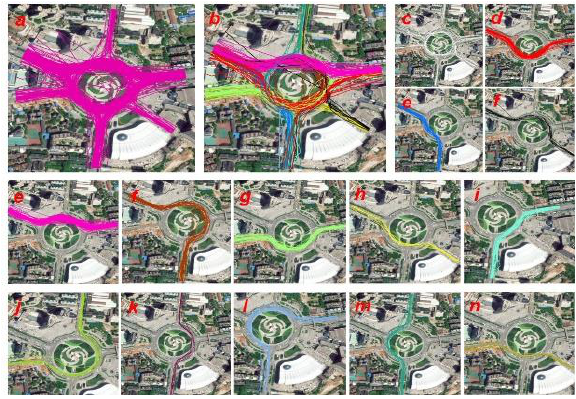
Figure 11. Clustering results of Guanggu square roundabout in Wuhan(a: original tracks; b: Clustering result; c: noise of cluster;